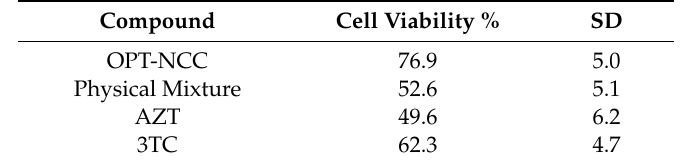
Table 10. Summary of in vitro cytotoxicity results.